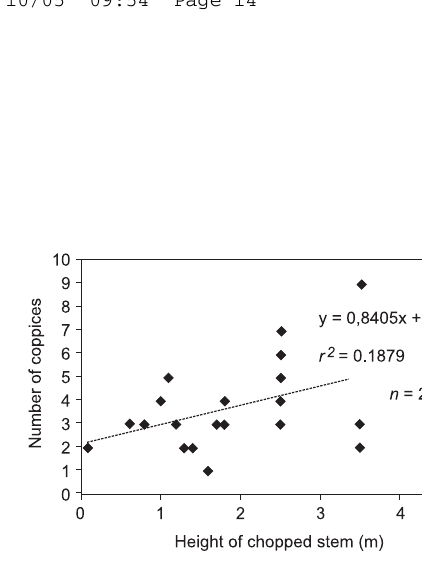
Fig. 7. Relationship between the height of chopping and the number of coppices for Catha edulis